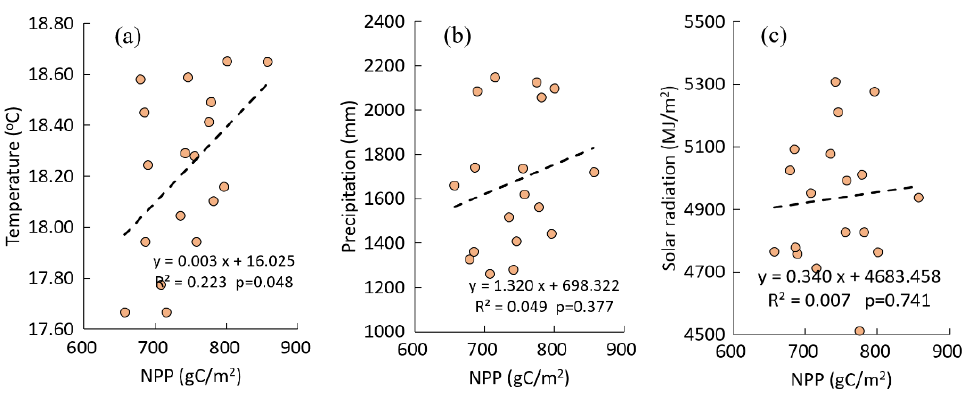
Figure 6. Scatters and fitted linear correlations between annual NPP and ( a ) temperature, ( b ) precipitation, and ( c ) solar radiation at the basin scale.